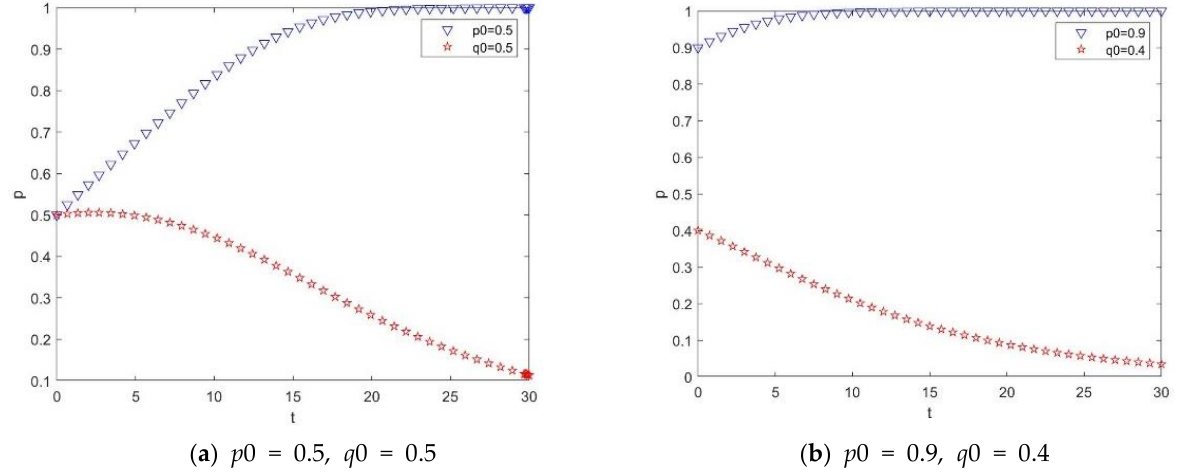
Figure 4. The effect of construction workers’ expected accident loss S 1 on the evolution results.